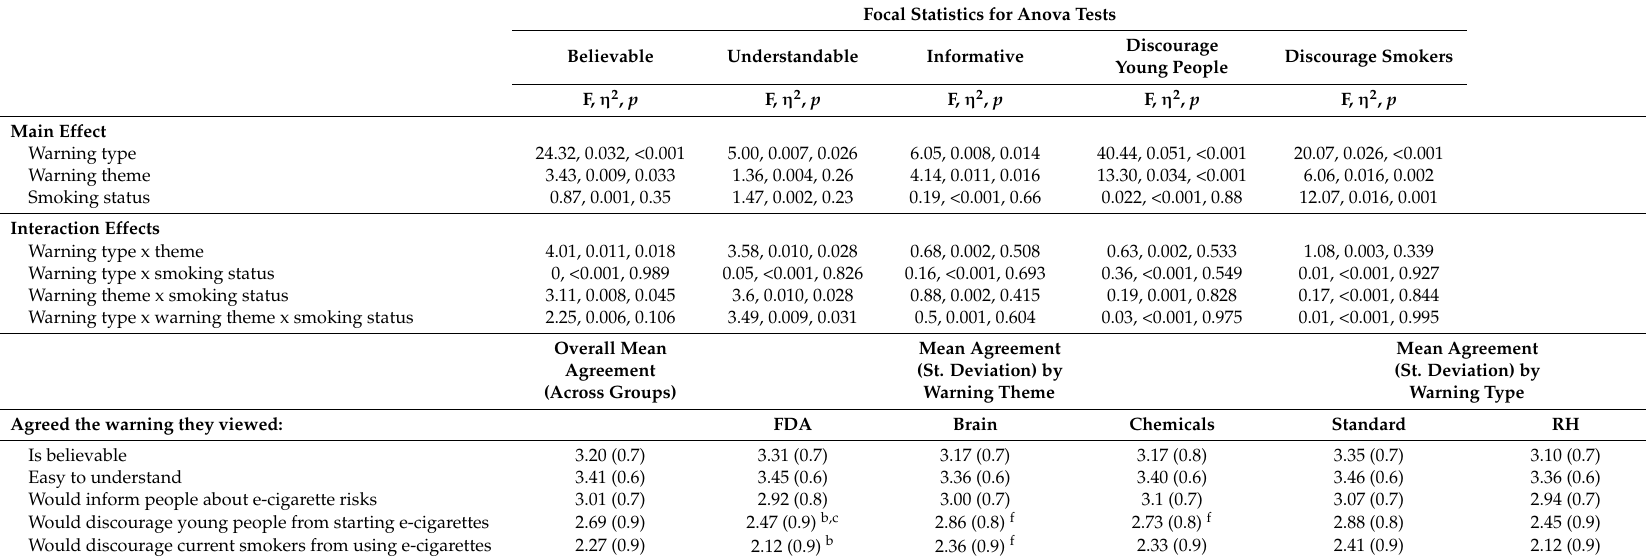
Table 4. Perceived effectiveness of e-cigarette